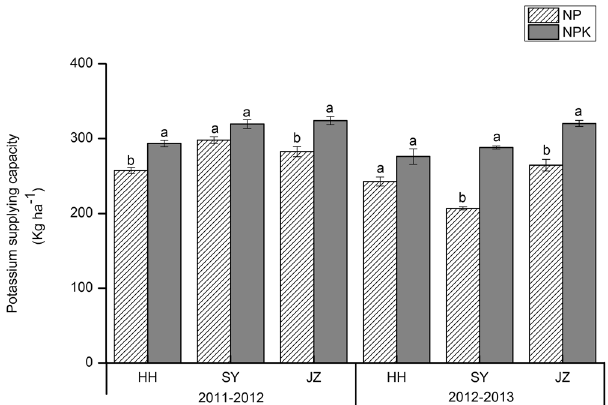
Figure 3. Potassium supplying capacity (kg ha − 1 ) in 1 st (2011–2012) and 2 nd (2012–2013) rotation. HH, SY and JZ represent Honghu, Shayang and Jingzhou respectively. Each value represent the standard error ( n = 3). Within a season, bars with different letters are significantly different at P < 0.05 according to LSD.